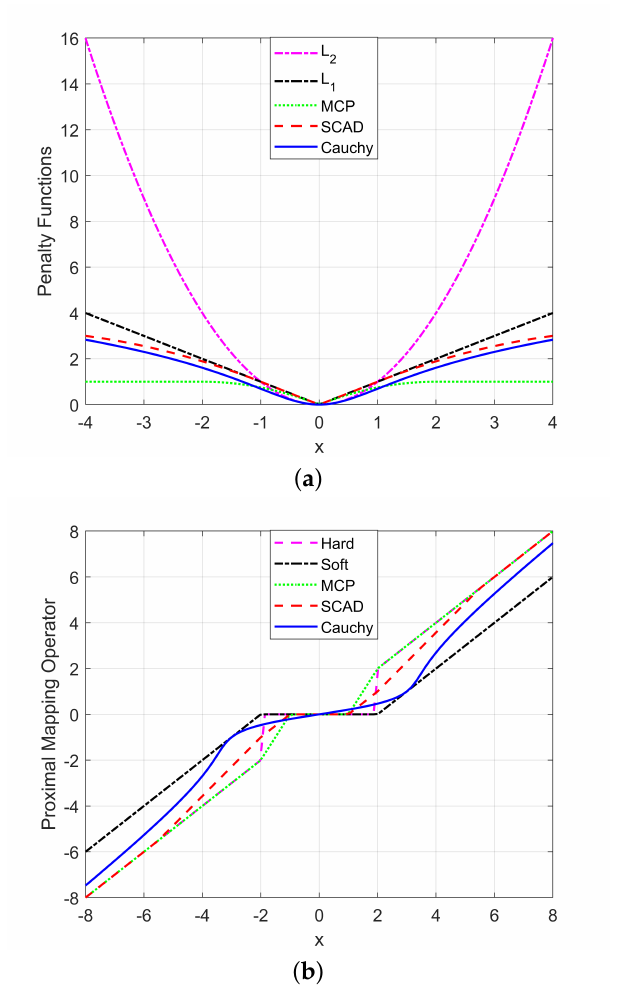
Figure 2. Different penalty functions. ( a ) Penalty functions. ( b ) Proximal mapping